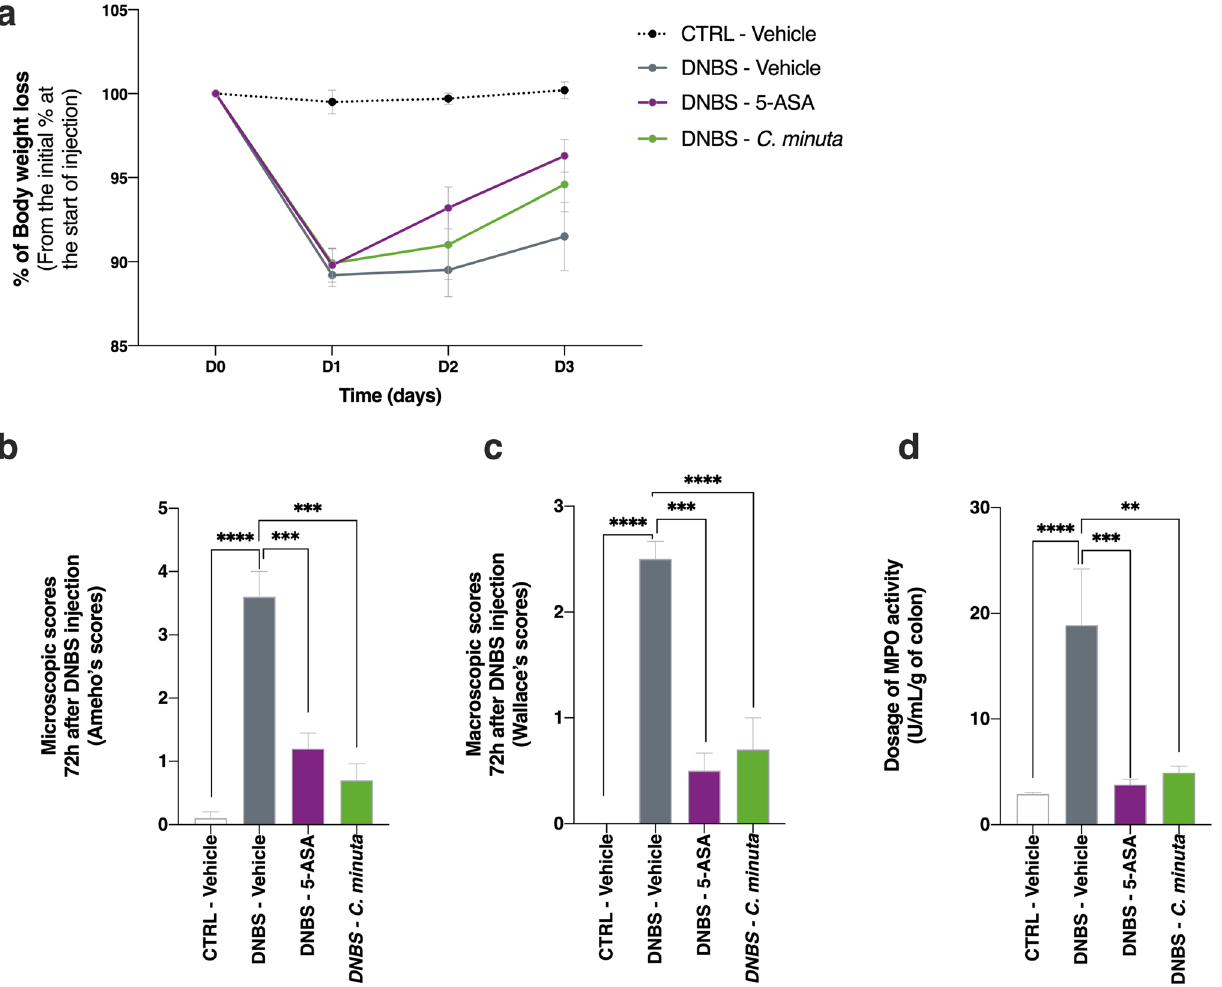
Figure 4. Effects of Christensenella minuta on DNBS-induced inflammation in mice. ( a ) Change in body mass after colitis was induced; ( b ) colon microscopic scores; ( c ) colon macroscopic scores; and ( d ) levels